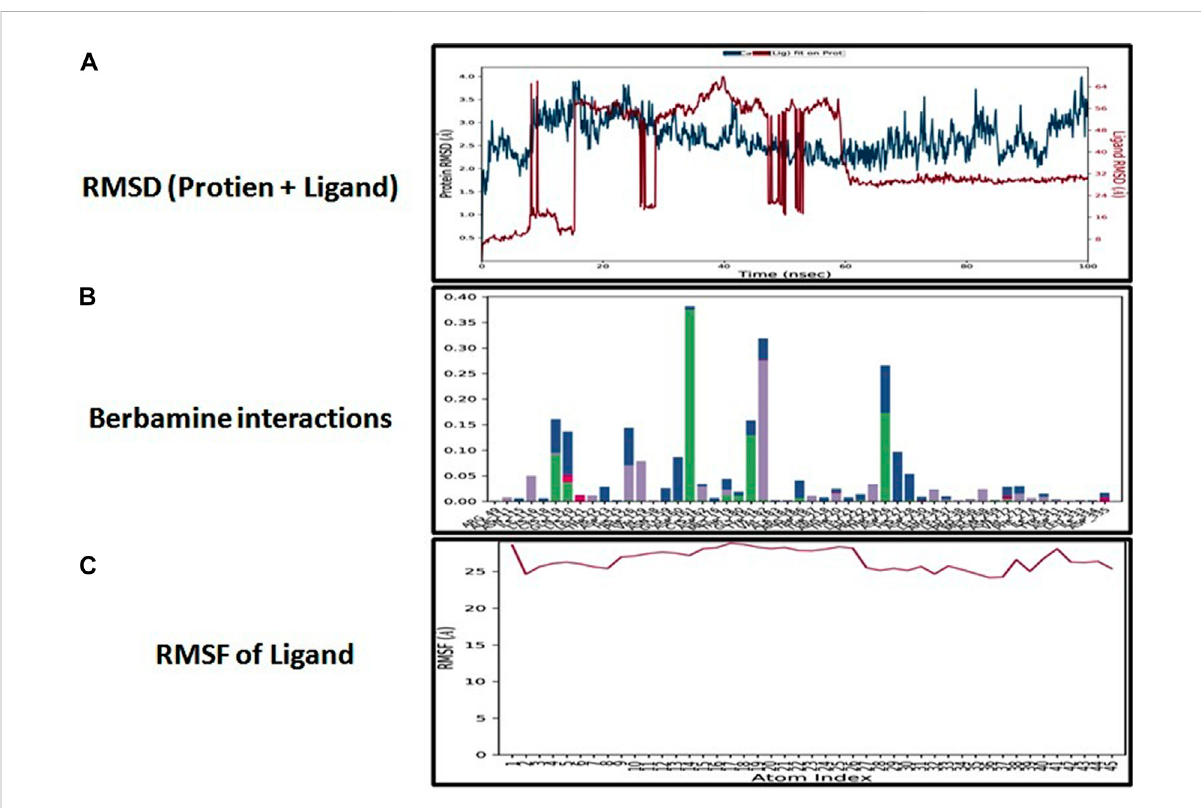
FIGURE 4 Represents root mean square deviation (RMSD) of mitogen-activated protein kinase (MAPK, PDB I.D: 5UOJ) and berbamine (A) , interactions (hydrogen bonds, hydrophobic interaction ionic and water bridges) of berbamine (B) , and root mean square fl uctuation (RMSF) of berbamine (C) obtained through Desmond software